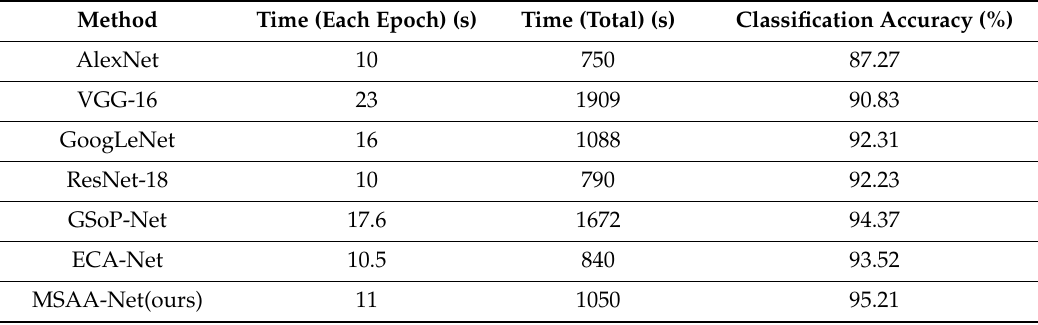
Table 7. The training time and accuracy on the Google dataset of SIRI-WHU.